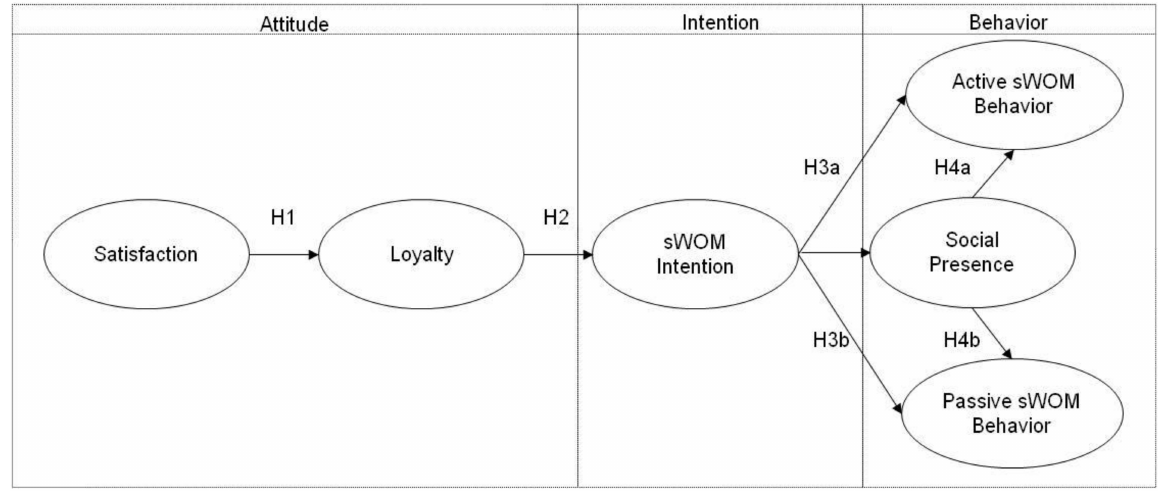
Figure 1. Attitude–intention–behavior-based research